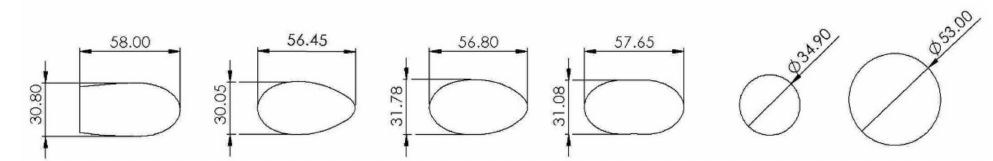
Figure 8. Seat tube cross-sections from left to right: complex 1, complex 2, complex 3, complex 4, and circular 34.9 mm and 53 mm.